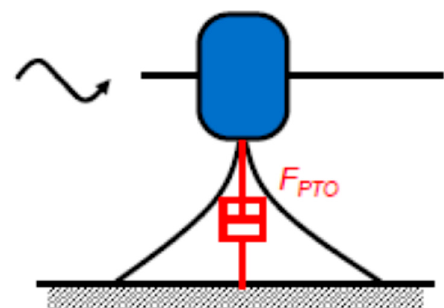
Figure 1. Schematic of a PTO system with a linear damper.